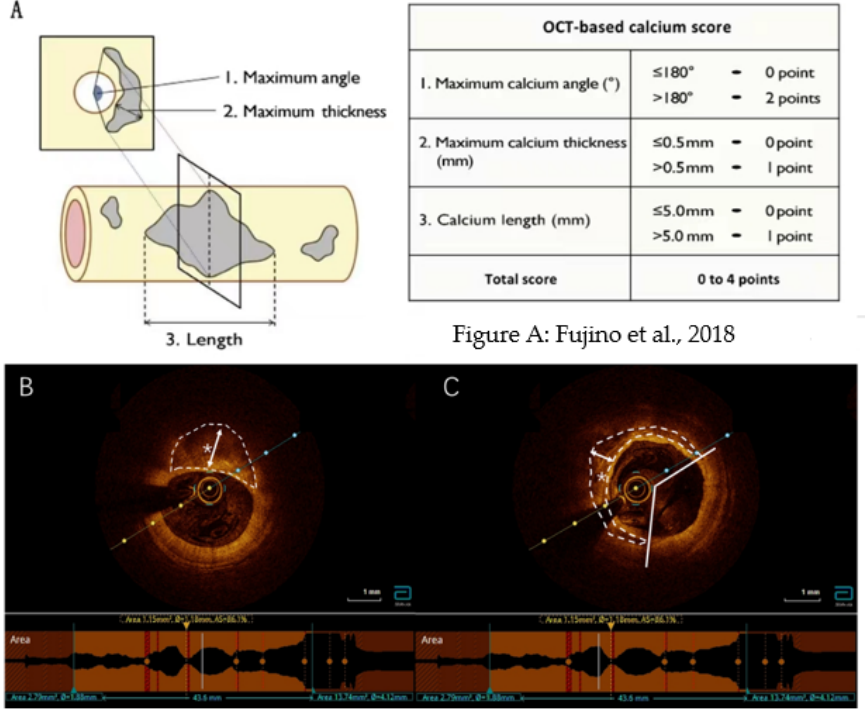
Figure 2. Calcification score based on optical coherence tomography. ( A ) Calcification scoring system based on optical coherence tomography (OCT). The OCT-based calcium score consists of three parameters obtained from the OCT images: maximum calcium angle, maximum calcium thickness, and calcium length. Each parameter was assigned 1 or 2 points, and the total score (0–4) was calculated. ( B , C ) Typical OCT calcification images. Calcium (*): The distance between the inner edge of calcium and the lumen surface is the calcification thickness, as shown by the white arrow, and the calcification angle is measured by a protractor centered on the lumen, as shown by a white straight line. OCT: optical coherence tomography. On this basis, Fujino et al. developed a calcification scoring system based on OCT that aimed to evaluate calcification severity and predict the stent expansion effect. Fujino et al. used three parameters (maximum angles, maximum thickness, and length) to evaluate each calcium deposition type in the target lesion using OCT. Fujino et al. assigned a score of 1 to 2 for each of the following conditions: maximum calcification angle of > 180° = 2, maximum calcification thickness > 0.50 mm = 1, and calcification length > 5 mm = 1. The total score (0–4) was calculated (Figure 2). On this basis, subjects with CAC shown by OCT were divided into two groups according to CAC severity: the 0–2 and 3–4 group. To ensure the accuracy of the experiment, two groups of patients were retested for CTRP9. All OCT data were analyzed using dedicated offline review systems (Abbott Vascular or Terumo) and expert consensus reports by three independent interventional cardiologists and reviewed by a third reader blinded to the clinical and angiographic information.